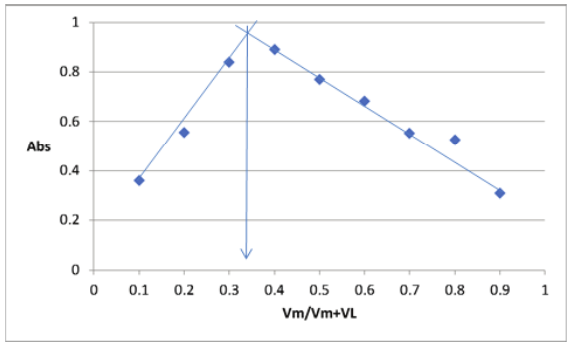
Table 6: Analytical performance for Bi(III) and Al(III) determination